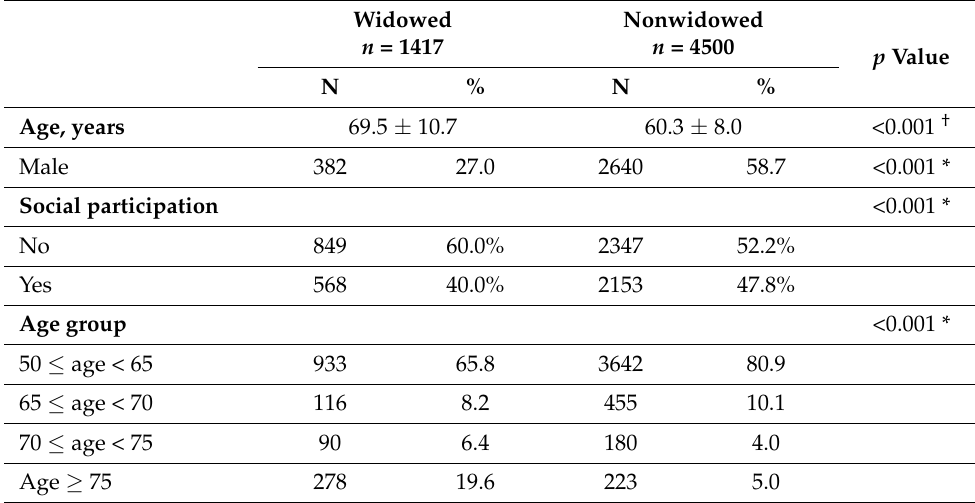
Table 1. Baseline demographics of participants who were widowed, married, and with cohabitants from the Taiwan Longitudinal Study on Aging (TLSA) waves IV–VI